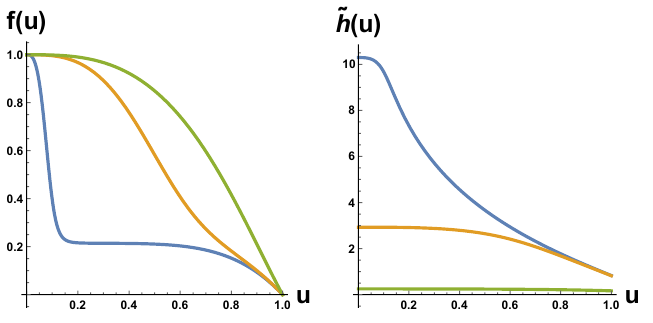
Figure 3 . The metric functions f ( u ) and ~ h ( u ) for a potential W ( X; Z ) = X 2 Z , u H = 1, (cid:10) = 0 : 24 ; 2 : 93 ; 10 : 29 and temperatures T=m (cid:24) 0 : 15 ; 0 : 02 ; 10 (cid:0) 5 (Green, orange,